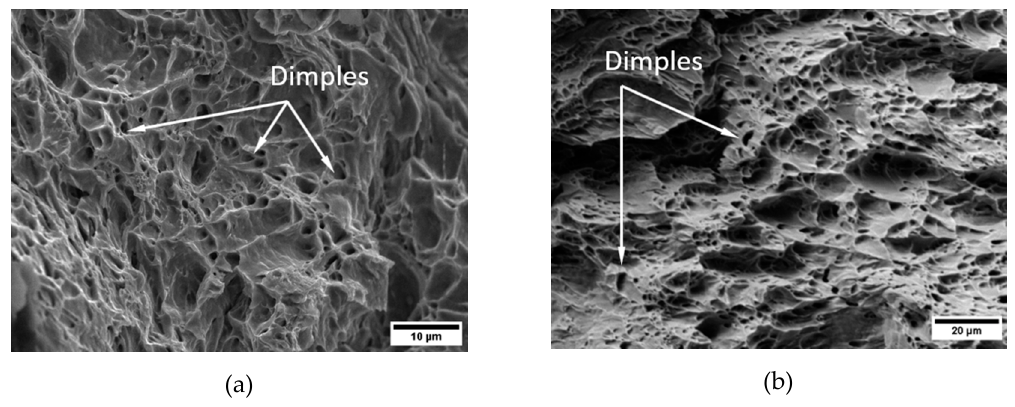
Figure 11. Dimpled fracture surface with a fibrous tearing, showing it to be ductile. ( a ) Horizontal specimen, ( b ) vertical specimen.